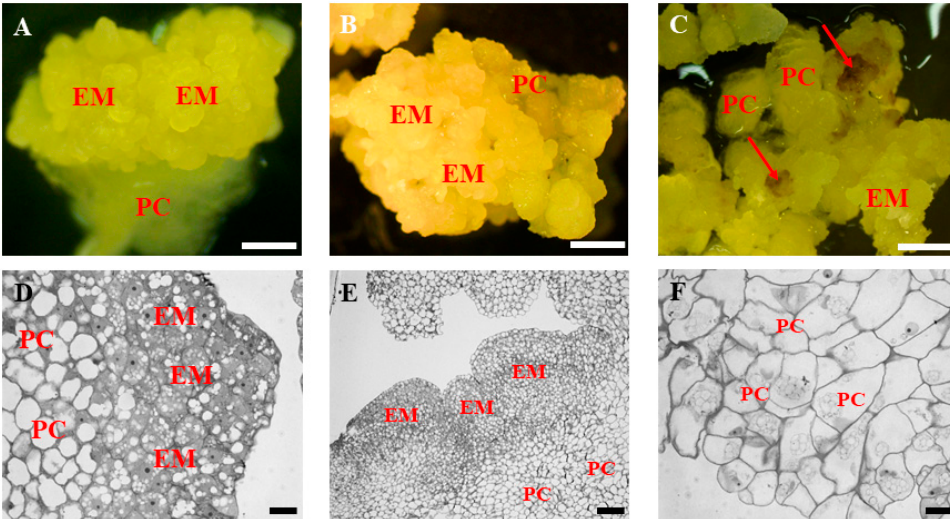
Figure 1. Morphology and histology of representative structures in the in vitro culture of Brachypodium distachyon callus. ( A – C ) General morphology and ( D – E ) histological section of the callus on the 30th ( A , D ), 60th ( B , E ), and 90th ( C , F ) day of cultivation. The red arrows point at brownish parts of the callus. EM: embryogenic masses, PC: parenchymatous cells. Scale bars, ( A – C )—1 mm, ( D )—10 µ m, ( E )—50 µ m, ( F )—10 µ m.